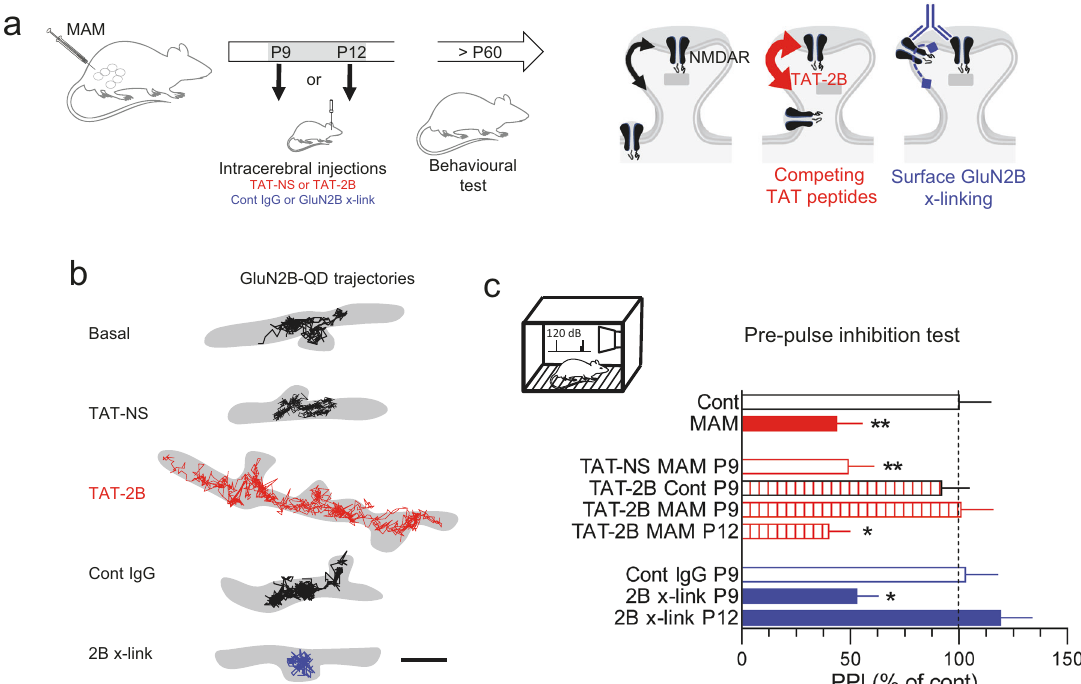
Fig. 6 Tuning GluN2B-NMDAR NMDAR surface dynamics alters sensorimotor gating in adults. a Schematic description of the experimental work fl ow: control of MAM-exposed pups received intracerebral injections during the second postnatal week of NMDAR surface diffusion modulators. b Representative trajectories (50 ms acquisition) of surface GluN2B-NMDAR on hippocampal neurons exposed to TAT-non sense (TAT-NS, 10 µM), TAT-2B (10 µM), control IgG (10 µg/ml), or IgG direct against extracellular epitope of the GluN2B-NMDAR (10 µg/ml). Scale bars = 500 nm (left/right). c The startle response, i.e., pre-pulse inhibition (PPI), was measured at P60 and compared between conditions ( n = 10 – 16 rats per group; * P < 0.05, ** P < 0.01, ANOVA 1 followed by Newman – Keuls multiple comparisons